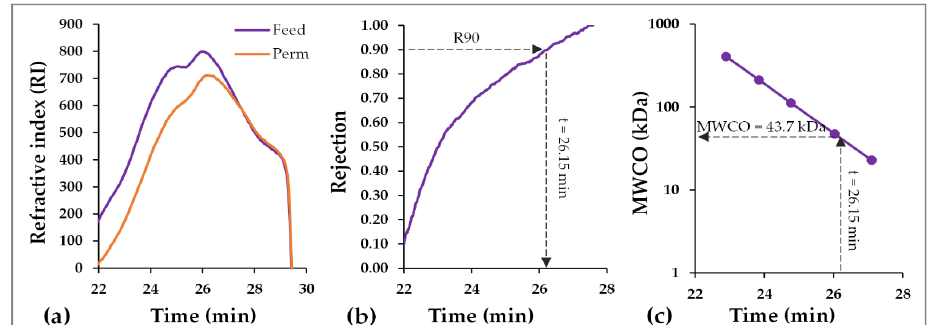
Figure 3. Typical data processing methodology for estimation of molecular weight cut-off (MWCO) from dextran rejection test results (data from the test after the 2nd sterilization cycle): ( a ) typical high performance liquid chromatography (HPLC) chromatogram from feed and permeate sample; ( b ) plot of the membrane rejection efficiency, determined by taking the ratio of RI time-series data of permeate and feed; ( c ) calibration curve with polysaccharide standards.